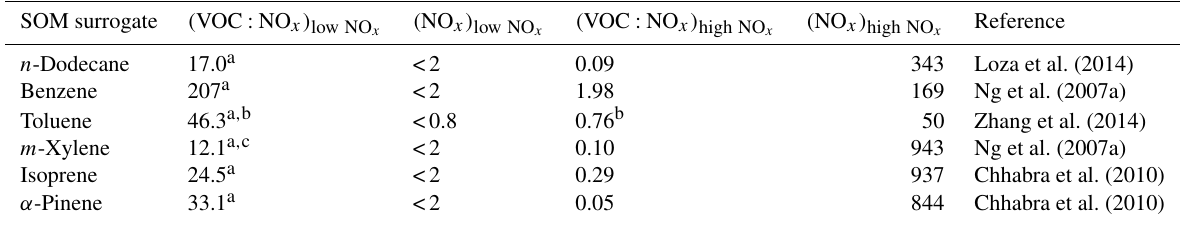
Table 2. Low and high VOC : NO x ratios in ppbppb − 1 and NO x concentrations in ppbv from chamber experiments used to model the influence of NO x on SOA formation.